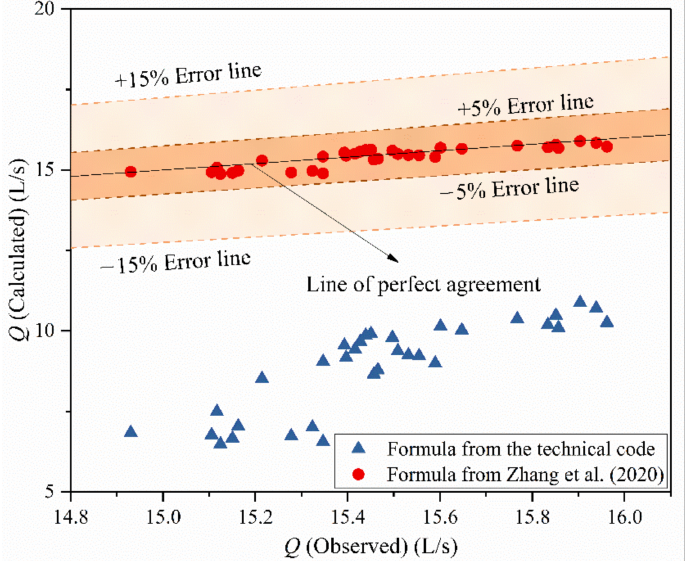
Figure 8. Comparison of the calculated discharge and the observed